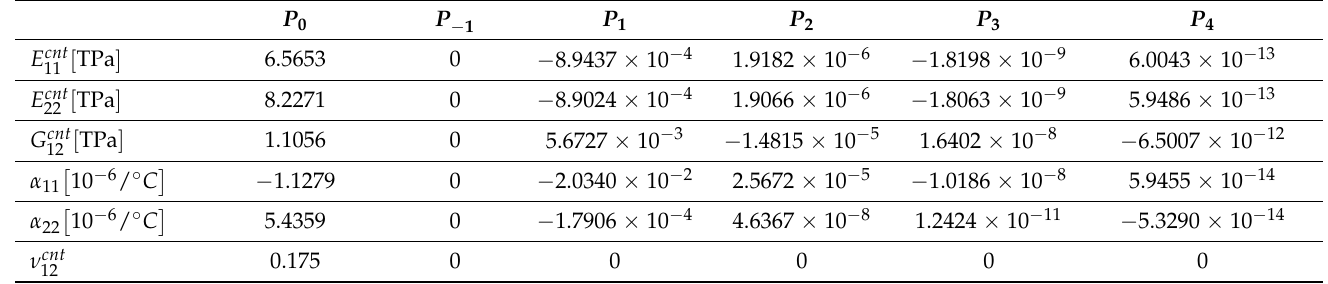
Table 3. Temperature-dependent coefficients of CNT material properties